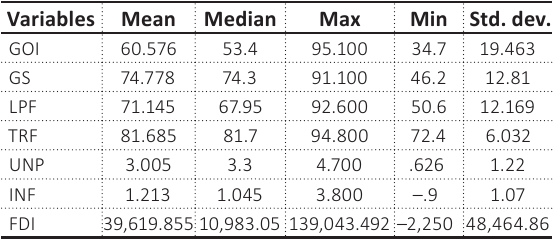
Table 1. Summary of descriptive statistics